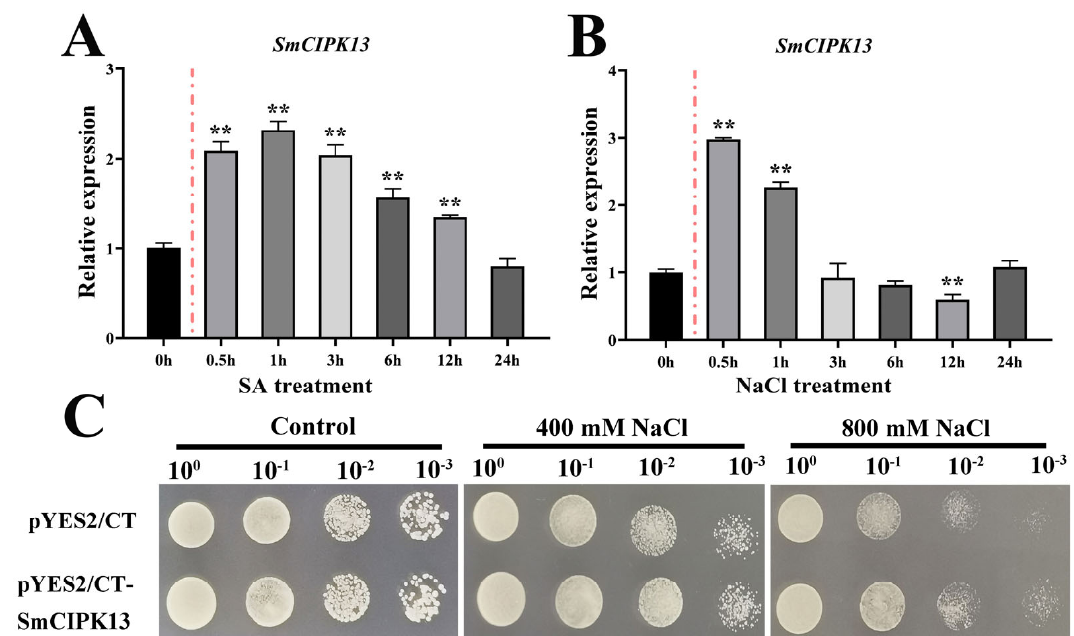
Figure 5. Expression analysis of SmCIPK13 under SA and NaCl treatment and characterization of its function in yeast. ( A , B ). SmCIPK13 was induced at expression levels of 0, 1, 2, 3, 6, 12 and 24 h by 80 μ M SA and 150 mM NaCl. ( C ). Growth of yeast that have been transformed with SmCIPK13 grown in SD/ ‐ Ura, SD/ ‐ Ura medium containing 400 mM and 800 mM NaCl. ( ** p < 0.01).